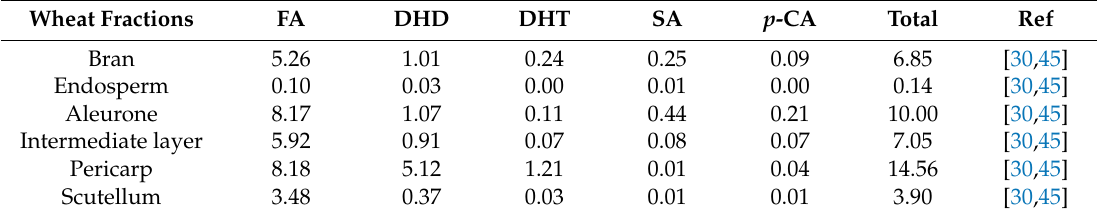
Table 5. Major phenolic acids from wheat grain tissues (mg/g dry matter) (adapted from Reference